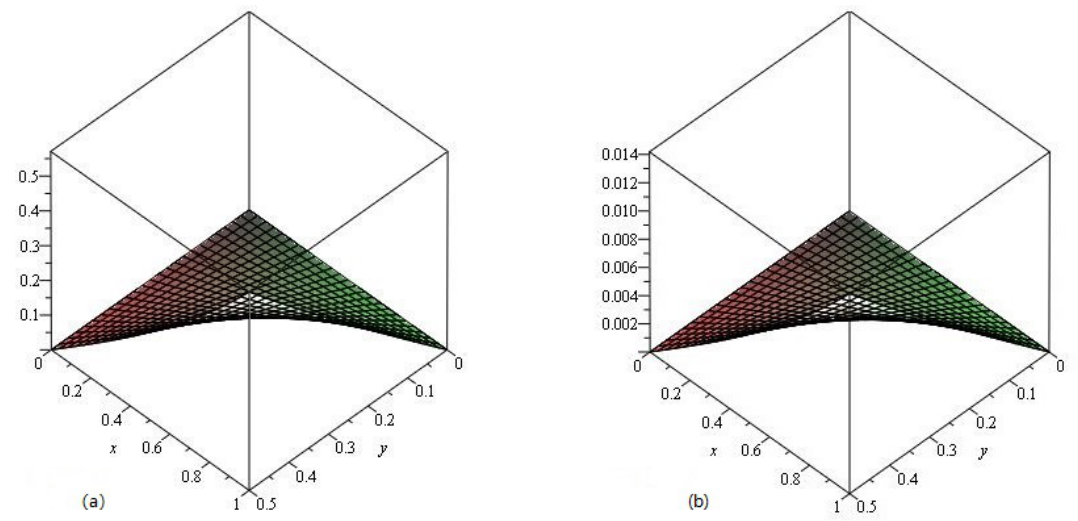
Figure 12. The LADM solution of υ ( x , y , z , t ) of Example 4.5 at ( a ) γ = 0.50 and ( b ) Error plot at γ =